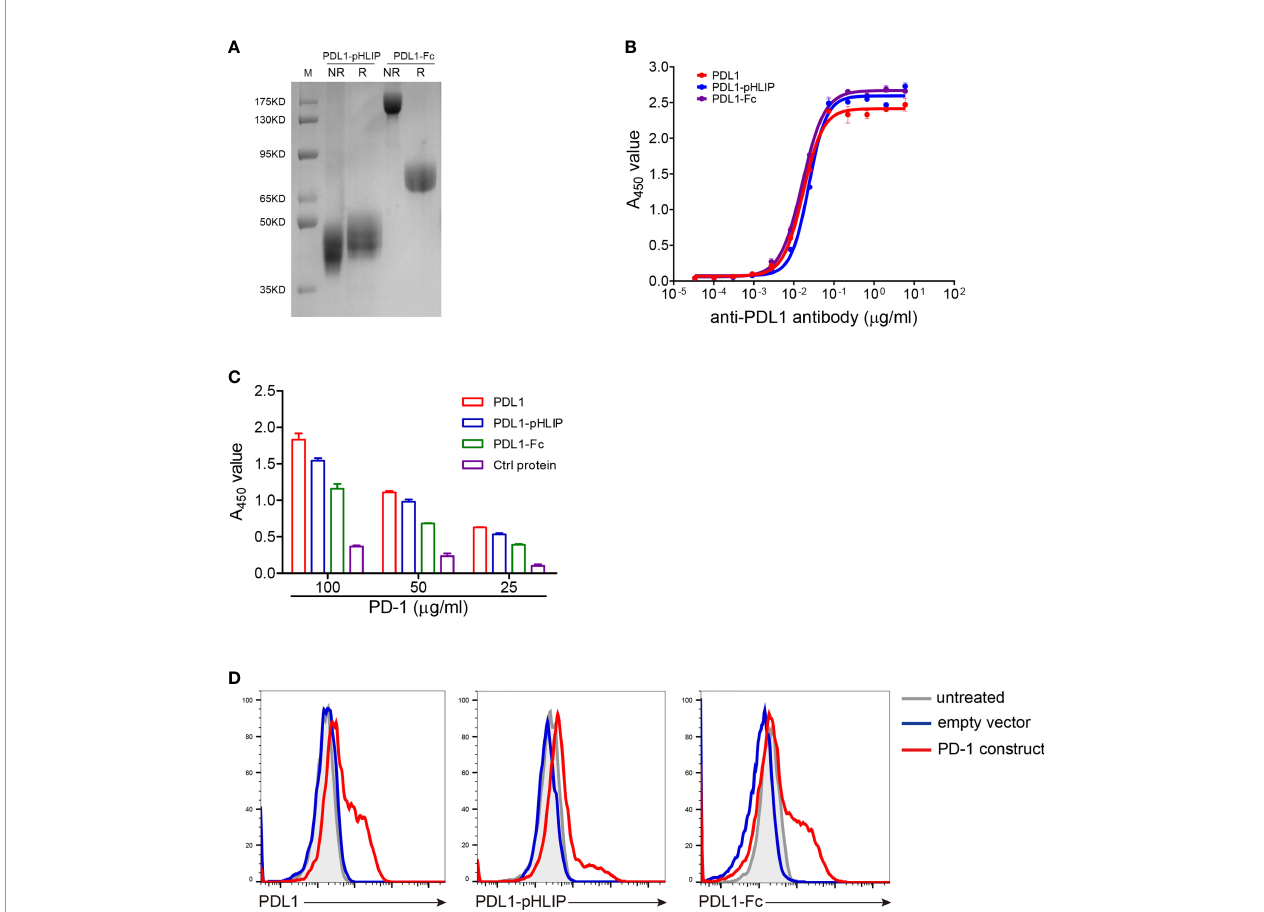
FIGURE 1 | Validation of recombinant mouse PD-L1-pHLIP protein binding its ligand PD-1. (A) Recombinant PD-L1-pHLIP and PD-L1-Fc proteins were examined by SDS-PAGE. R, reducing; NR, nonreducing. (B) The binding capacity of PD-L1/PD-L1-pHLIP/PD-L1-Fc to an anti-PDL1 monoclonal antibody was determined by ELISA. (C) The ability of PD-L1/PD-L1-pHLIP/PD-L1-Fc to bind recombinant PD-1 protein was determined by ELISA. (D) Murine PD-1 construct was transiently introduced into HEK293T cell lines. The engagement of PE-conjugated PD-L1/PD-L1-pHLIP/PD-L1-Fc with membrane-bound PD-1 on the surface of HEK293T cells was examined by fl ow cytometry. Representative plots from three independent experiments were shown. The data were pooled from three experiments with similar